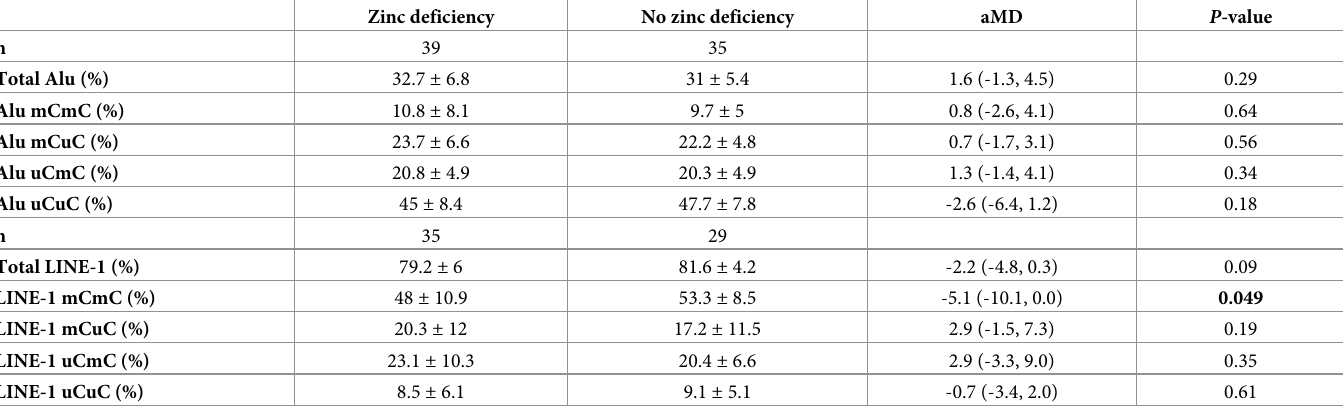
Table 7. DNA methylation levels in young adult offspring according to maternal zinc deficiency in late pregnancy.